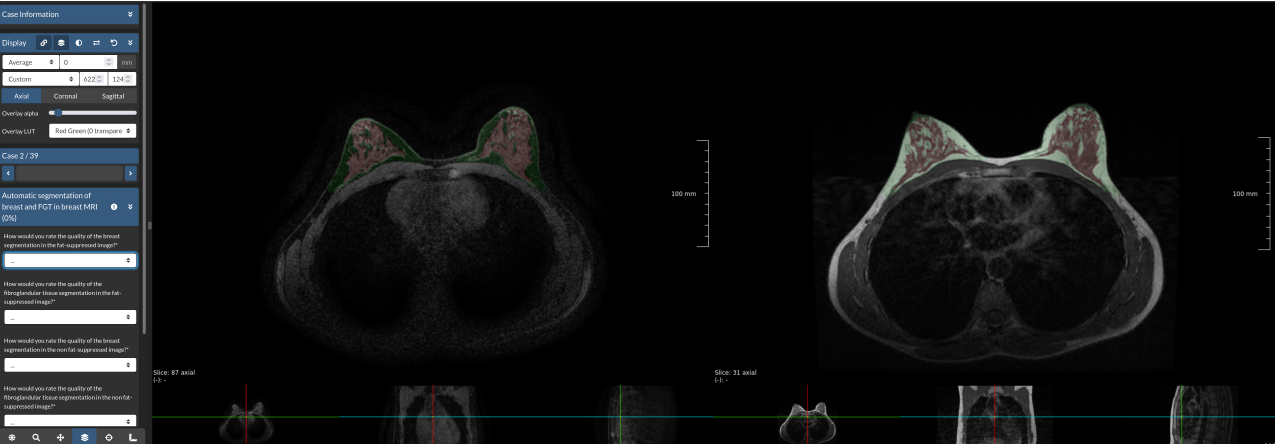
Figure 3. Screenshot of reader study set-up. The Grand Challenge platform allows the set-up of a web-based reader study with a fully functional medical imaging viewer. In this reader study, we showed participants the same WOFS and FS case side-by-side, and they were asked to answer the questions on the left side of the screen, which, in this case, were multiple choice